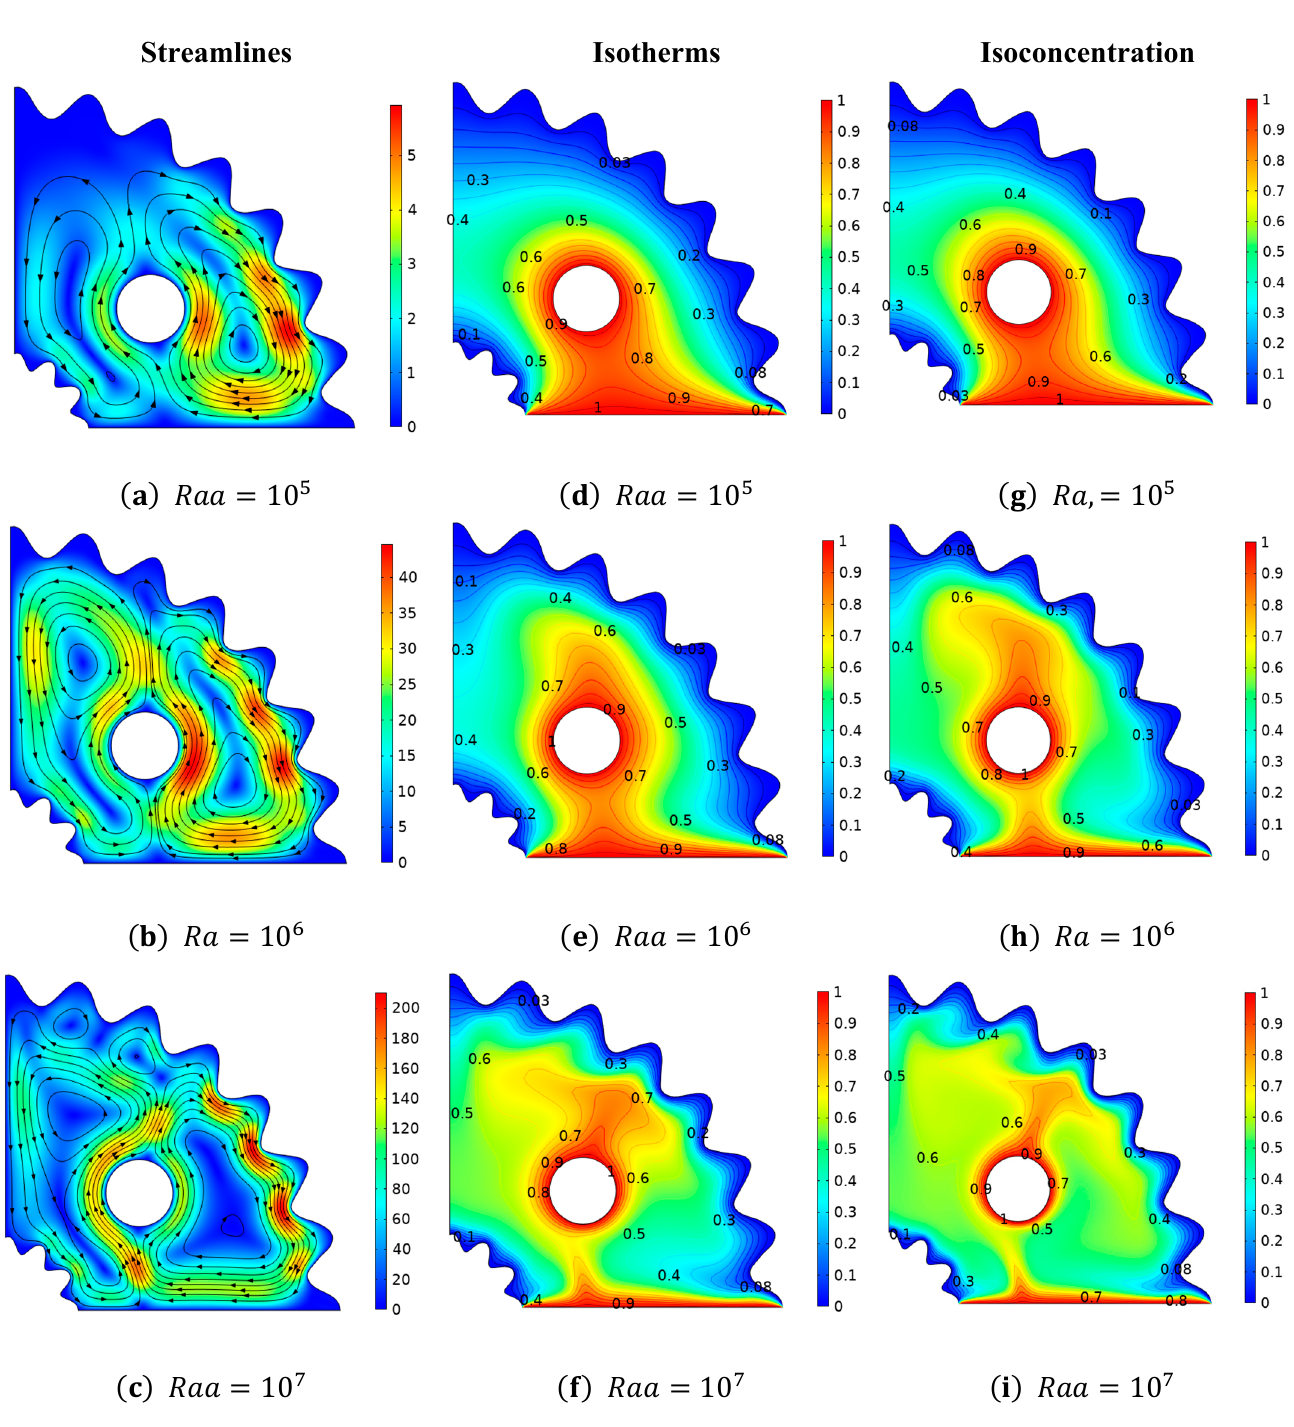
Figure 6. Deviation of ( a – c ) stream lines, ( d – f ) isotherms, and ( g – i ) isoconcentration with respect to Rayleigh number ( Ra ).